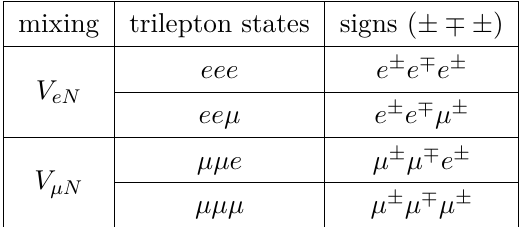
Table 2 . All possible trilepton final states in charge and flavor spaces, assuming either | V eN | 6 = 0 or | V = 0 µN | 6